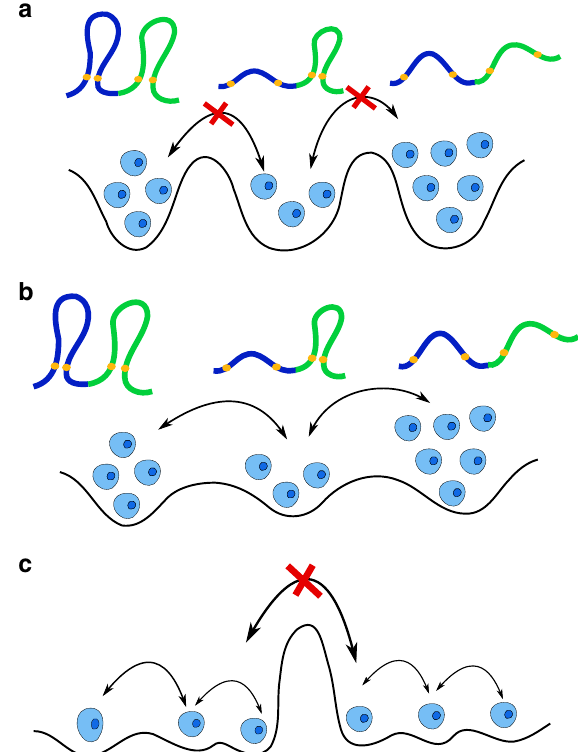
Fig. 7 Schematic of the Genomic Folding Landscape (GFL). a Static heterogeneity: cell subpopulation occupies distinct local minima in the GFL, with each minimum representing a stable organization. The energy barrier is too large for transitions between different local minima on a biological time scale (one cell cycle). b Dynamical heterogeneity: the energy barrier between local minima on the landscape is small enough which allows the dynamic transition between different subpopulations. c Combination of two different types of heterogeneity. In all three scenarios, the [ P mn , 〈 R mn 〉 ] paradox arises. The loci contacts are in orange. The polymer conformation sketches are not shown in this scenario due to insuf fi cient